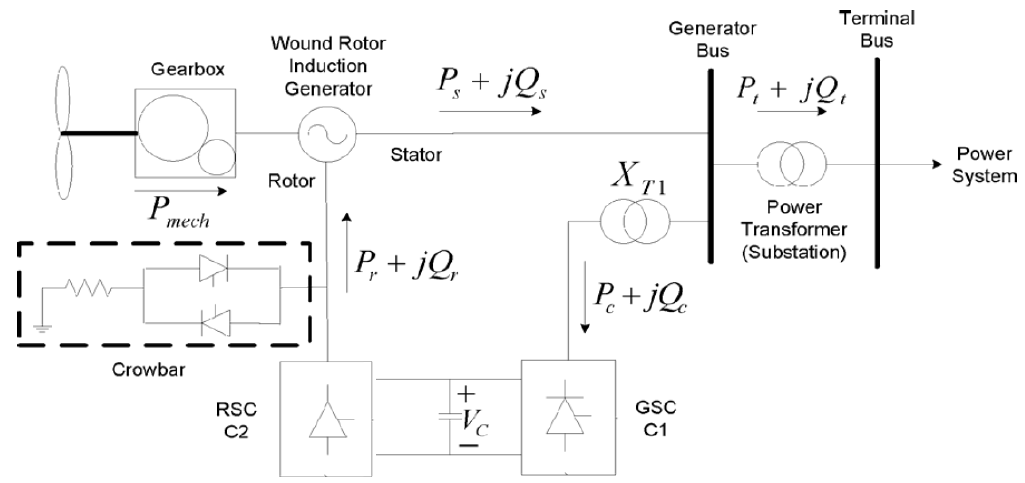
Figure 1. Schematic diagram of a doubly-fed induction generator.